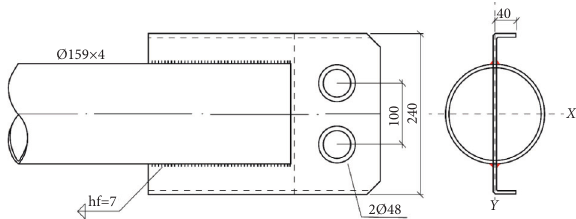
Figure 2: The connection style of the